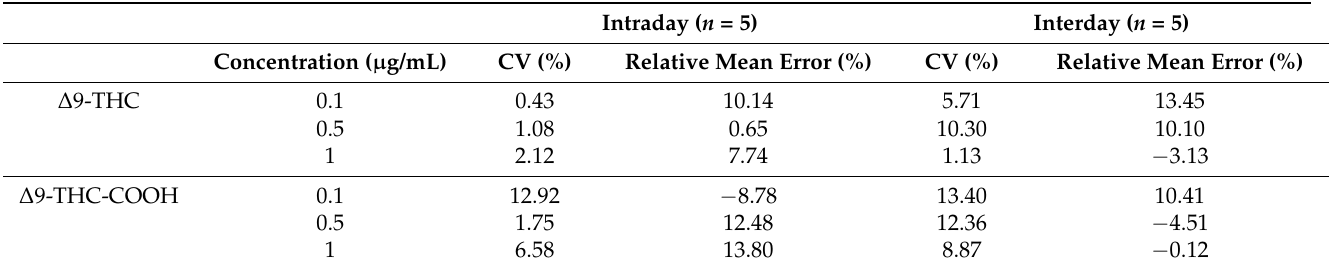
Table 2. Precision and accuracy obtained for ∆ 9-THC and ∆ 9-THC-COOH.